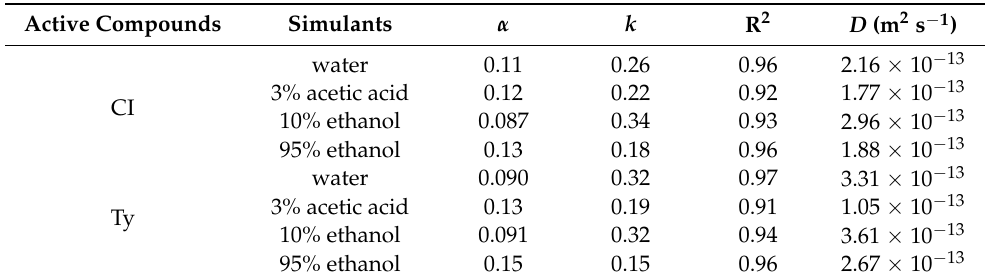
Figure 3. Release of CI and Ty from PLA/FGSA-CI and PLA/FGSA-Ty bilayer films into liquid food simulants: water ( a ); 3% acetic acid ( b ); 10% ethanol ( c ); 95% ethanol ( d ). Table 3. Diffusivity and diffusional exponent of CI and Ty in obtained active bilayer films in contact with different liquid food simulants.